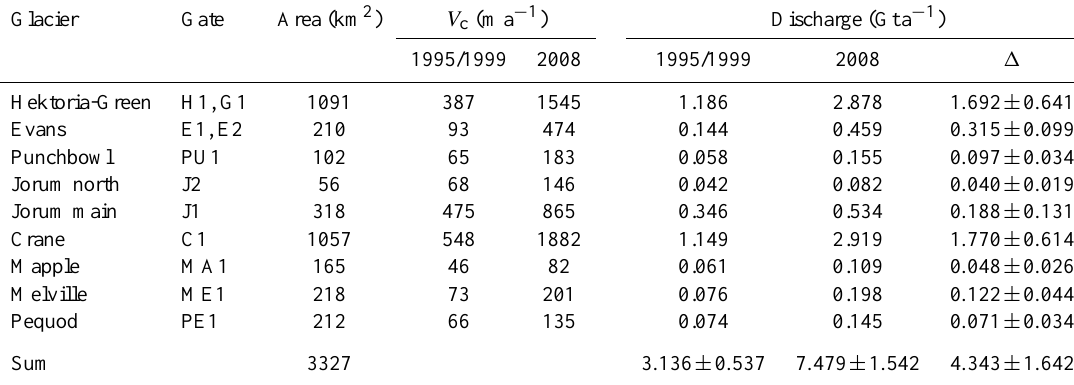
Table 2. Drainage area, velocities at the centre line of the gate ( V c ), and discharge of glaciers in the Larsen-B embayment across the gates shown in Figs. 3 and